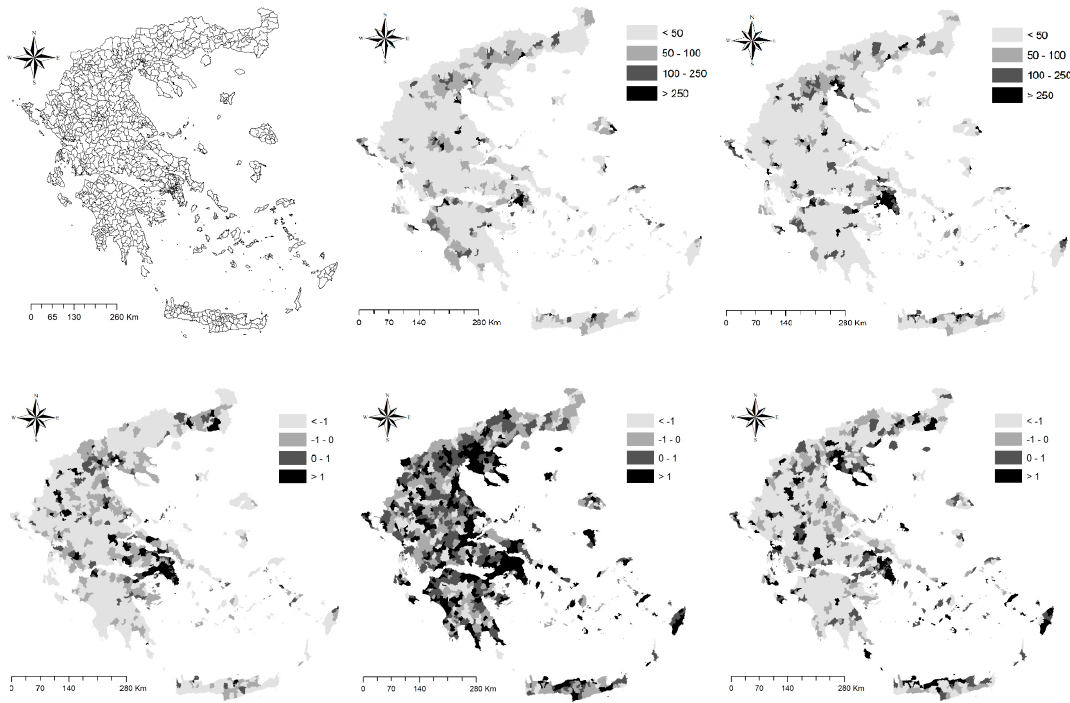
Figure 3. Maps illustrating Greek municipalities (upper left), population density (inhabitants/km 2 ) for 1961 and 2011 (upper middle and upper right) and population growth rate (%) over three decades (1961–1971: lower left; 1981–1991: lower middle; 2001–2011: lower right).